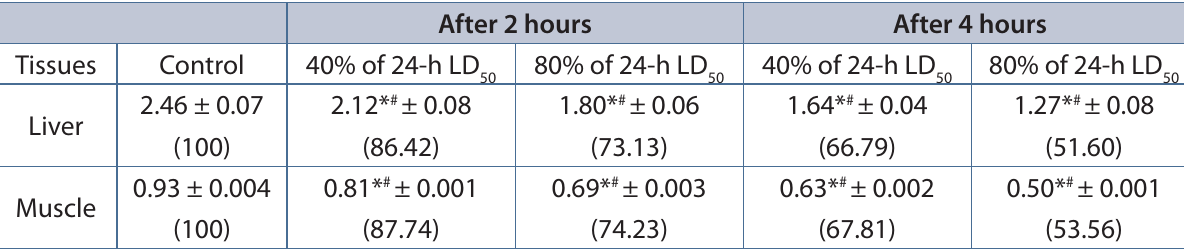
Table 2. Effect of 40% and 80% of 24-hour LD liver and muscle tissue of albino mice